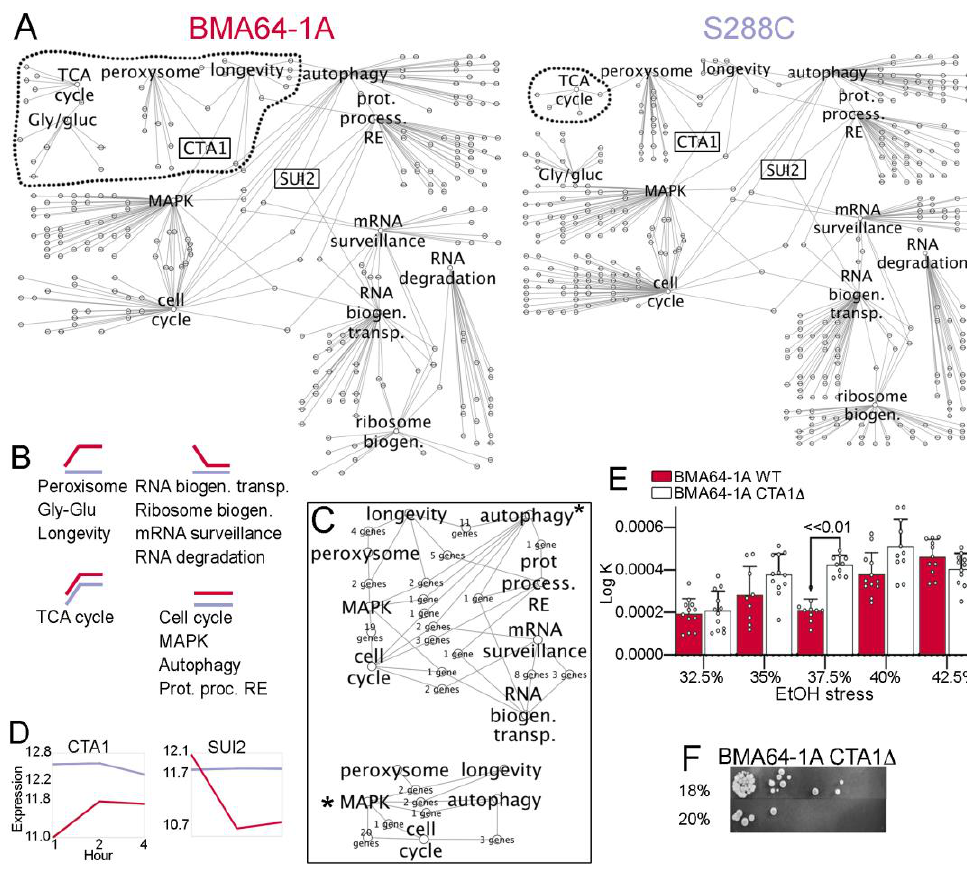
Figure 4. Essential subsystems showing phenotypic differences using BMA64-1A and S288C as models. ( A ) Comparison between the networks modeled based on the time-course and KEGG data. The dotted line delimits the communities with expression activation profiles. ( B ) Overview of the time-course expression profiles from the data shown in ( A ) under stress. ( C ) Analysis of information flow from pathways labeled with “*”. ( D ) Time-course landscapes of the crucial genes we suggest triggering the differences in the expression phenotype of cells under stress. ( E ) Population rebound after stress relief in WT and BMA64-1A CTA1 ∆ strains. ( F ) Spot test of the BMA64-1A CTA1 ∆ strain. The white dots (nodes) in ( A ) and ( C ) are genes/proteins.